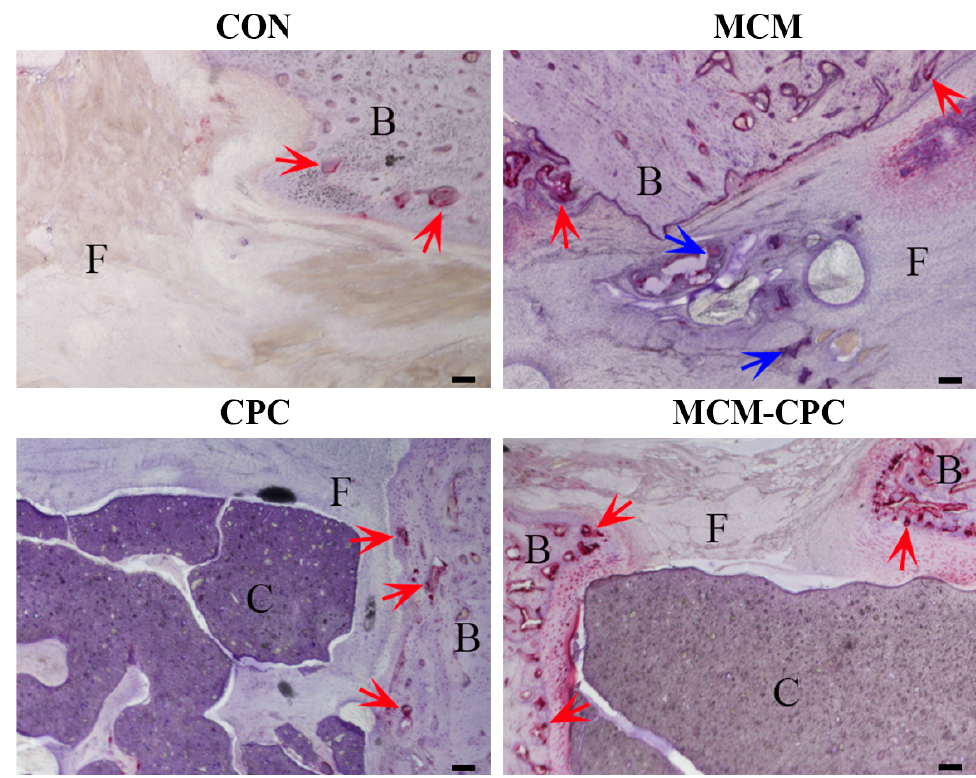
Figure 8. Representative tartrate resistant acid phosphatase (TRAP) stained sections of the defect area 8 weeks post-surgery (B: bone, F: fibrous tissue, C: remaining CPC; blue arrows: remaining MCM, red arrows: TRAP positive cells; scale bars = 100 µm).